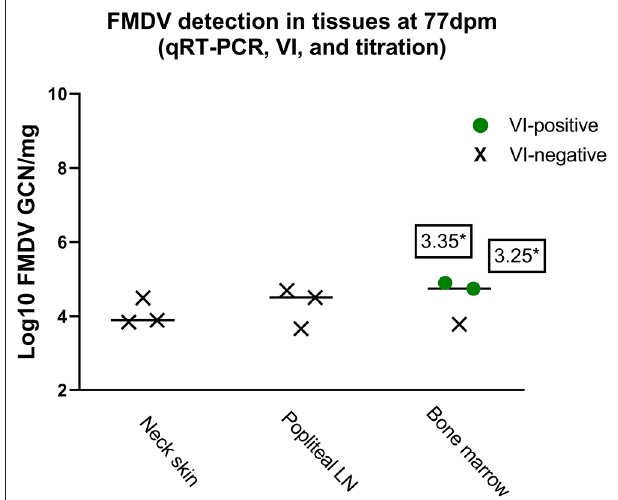
FIGURE 5 | FMDV detection in select tissue samples at 77 days post mortem. FMDV quantities (log 10 GCN/mg) in samples of submandibular lymph nodes, neck skin, and bone marrow harvested from carcasses of pigs infected with FMDV A24 Cruzeiro after 77 days of storage at 4 o C. Colored symbols indicate samples from which infectious virus was isolated, while X indicate virus isolation-negative samples. *FMDV titers in two samples of virus isolation-positive bone marrow were 10 3.35 and 10 3.25 TCID 50 /g, respectively. All symbols represent individual sample replicates ( n = 3), horizontal lines are